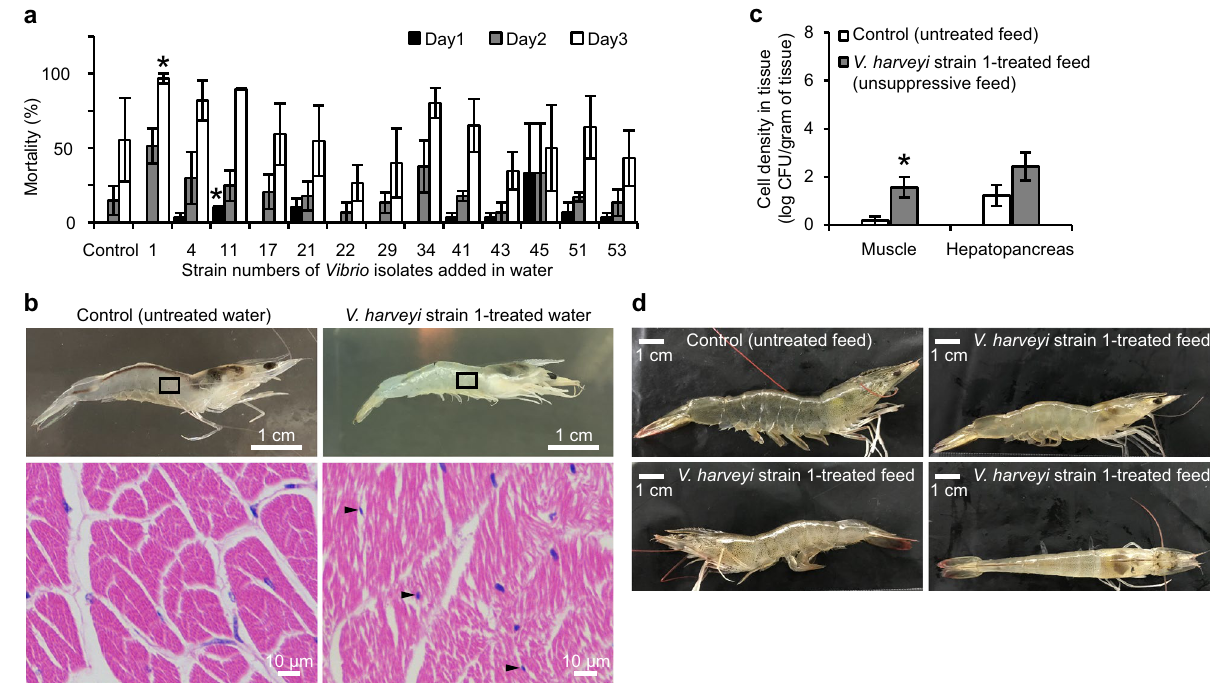
Figure 2. Pathogenicity of Vibrio isolates on Li. vannamei . ( a ) Mean mortality percentage of Li. vannamei after a 3-day challenge with 13 Vibrio isolates that proliferate fast in LB broth and (b) the consequential disease symptoms in the muscle of Li. vannamei cultivated in V. harveyi strain 1-treated water. ( b ) The muscle of the V. harveyi strain 1-treated Li. vannamei showed extensive whitish-opaque necrosis (upper right), which was not observed in that of the control treatment (upper left). Hematoxylin and eosin (H&E)-stained sections (bottom row) displayed the enlargement of the squared areas of the corresponding Li. vannamei . The necrotic muscle (lower right) arranged abnormally with ruptured muscle fibers, degraded muscle and (curved) rod-shaped and bacterial-sized cells (indicated by arrows). ( c ) Bacterial cell density in the muscle and hepatopancreas of Li. vannamei , which was determined on TCBS agar after 5 days of feeding with V. harveyi strain 1-treated feed in the first feeding test. *Statistically significant difference compared with the corresponding untreated control scored at the same time. Error bars represent S.E.M. ( N = 3 ( a ) and 24 ( c )). ( d ) Gross signs of Li. vannamei fed with V. harveyi strain 1-treated feed, which showed similar symptoms as described in ( b